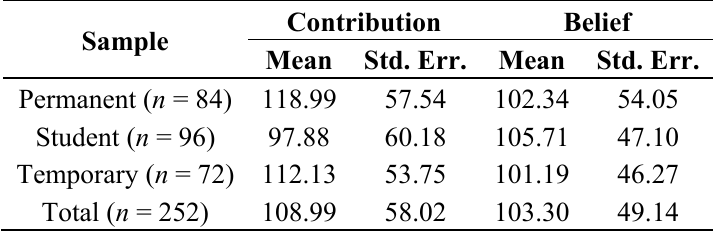
Table A3. Unconditional contributions and